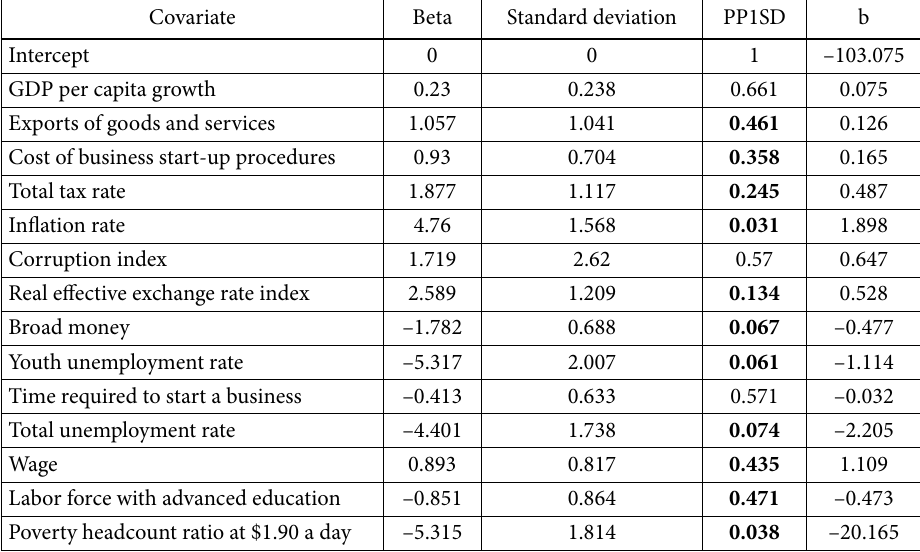
Table 3. Marginal posterior summary estimates for generalized ridge regression in case of Hungary (source: own results) Covariate